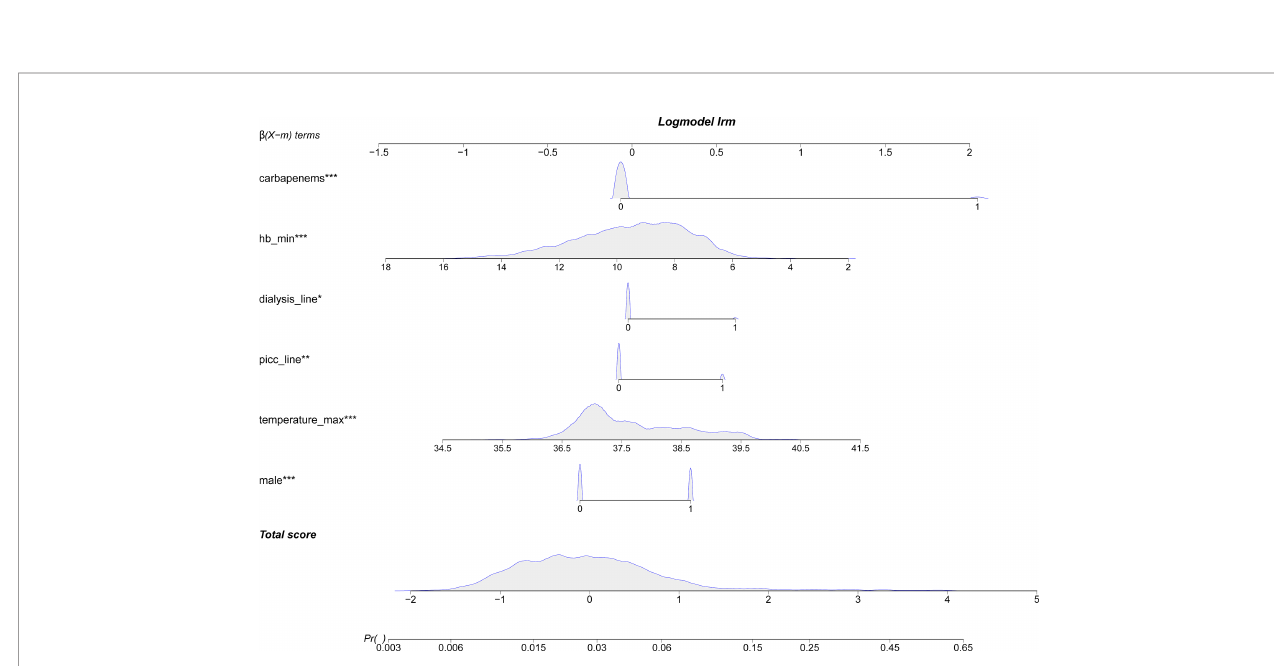
FIGURE 5 | Nomogram to predict the acquisition risk of CRO of patients with the fi rst ICU